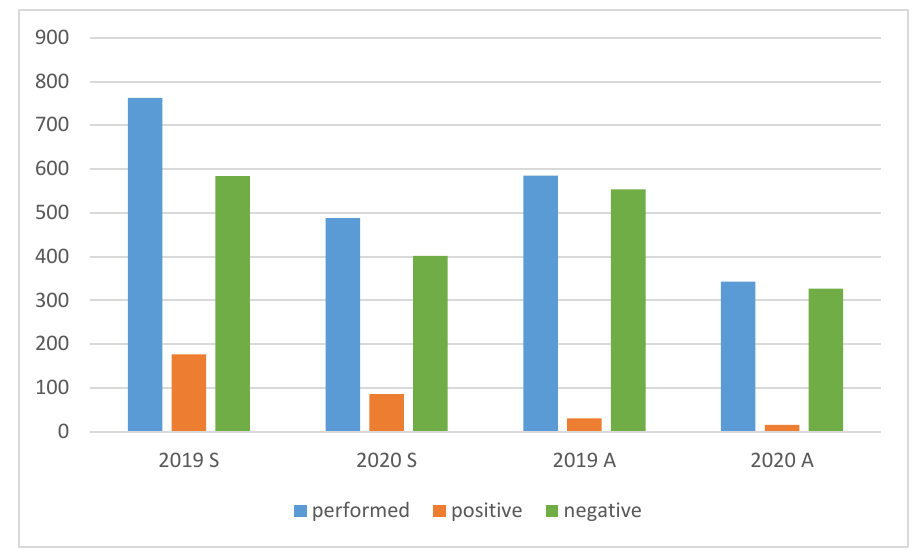
Figure 11. Comparison of rotavirus tests. Table 9. Comparison of rotavirus tests.